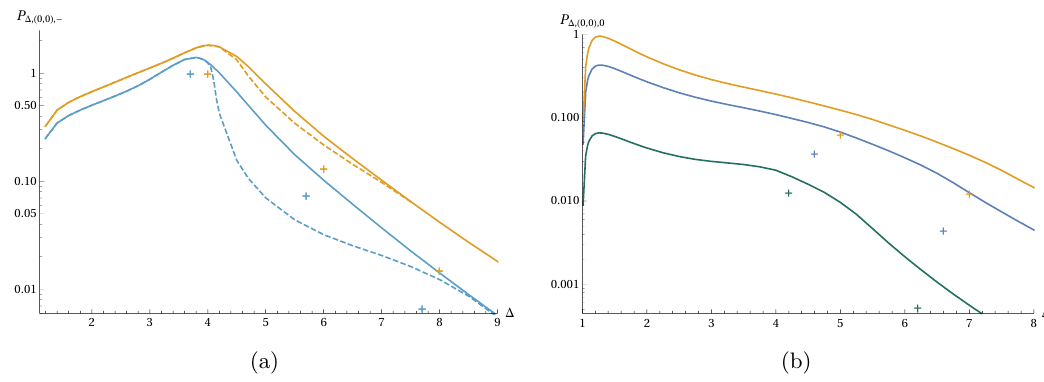
Figure 23 . Left: upper bound on the squared OPE coe(cid:14)cient of a charged scalar as a function of its dimension for (cid:1) = 1 : 85 (blue line) and (cid:1) = 2 : 0 (orange line). Dashed lines are the bounds with the further assumption that the scalar is the lightest in the spectrum. Right: upper bound on the squared OPE coe(cid:14)cient of a neutral scalar as a function of its dimension for (cid:1) = 1 : 6 (green line), (cid:1) = 1 : 85 (blue line) and (cid:1) = 2 : 0 (orange line). The bounds have been computed at (cid:3) = 16. Crosses corresponds to the fermion GFT values. Both plots are given in the log scale. operator is the lightest in the spectrum. We do not plot the dashed lines on (cid:12)gure 23(b) because they almost coincide with the solid